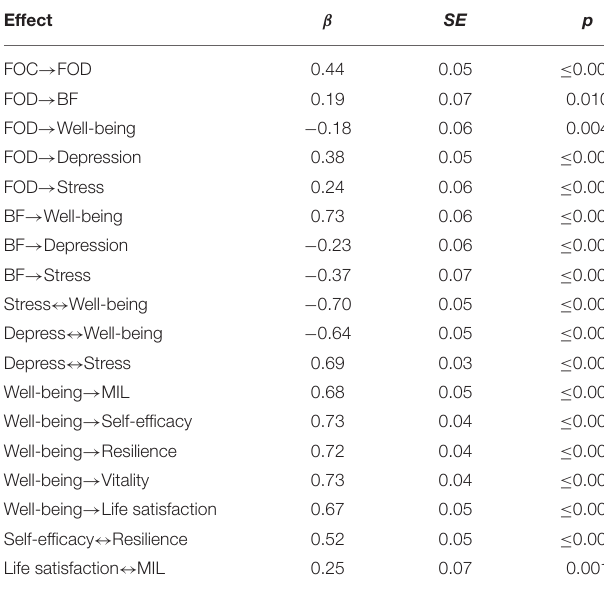
TABLE 3 | Standardized regression coefficients ( β ) and standard errors ( SE ) for direct